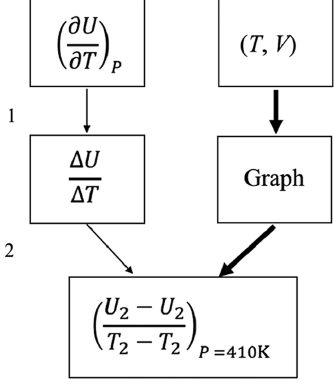
FIG. 15. GA strategy without considering